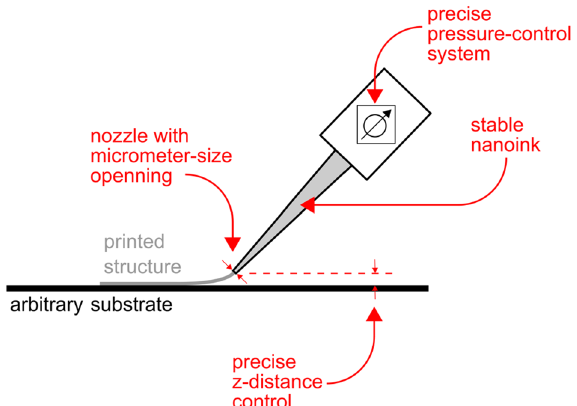
Figure 2. Sketch demonstrating Ultra-Precise Deposition (UPD) approach. The key feature of this technology is that high-viscosity paste (85 wt% of solid content) is extruded using a narrow printing nozzle (0.5–10 µm), which gives 1–10 µm feature size with an excellent aspect ratio in a single pass. This is achieved by a proper interplay between the paste properties, the process parameters, and the nozzle design. Finally, no electric field is